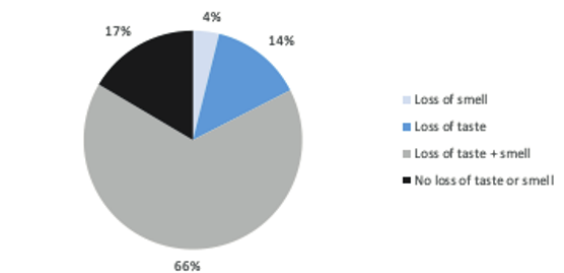
Figure 2. Loss of smell and taste.